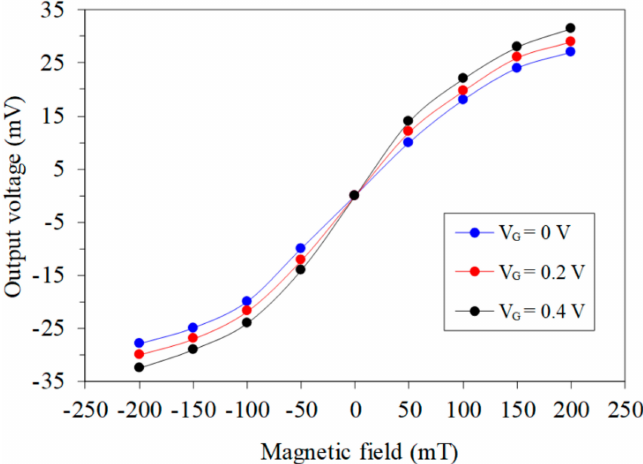
Figure 8. Tested OV in the x -axis magnetic